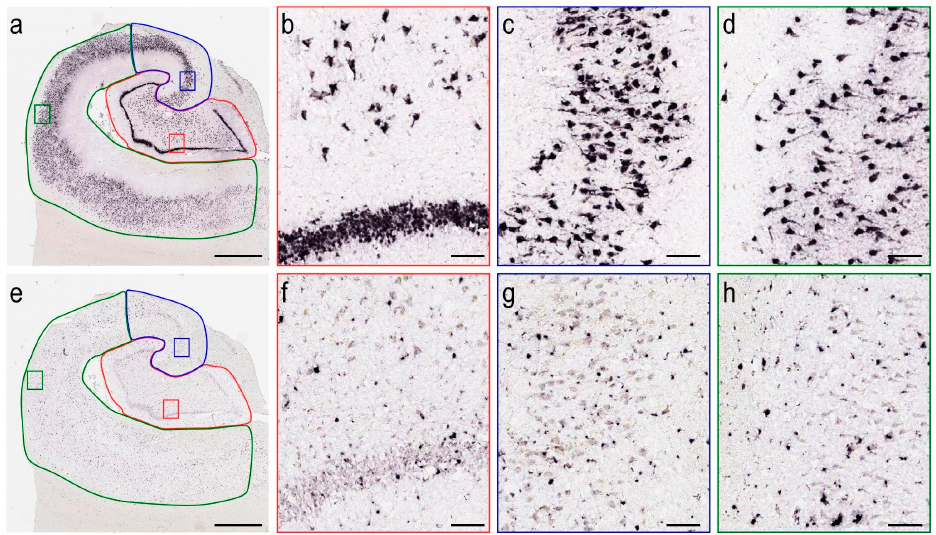
Figure 2. VGLUT1 and GAT1 mRNA immunoreactive profiles in the hippocampal sub-regions. This material was obtained from the donor H14.09.074. VGLUT1 ( a ) positive cells are observed at high-resolution in the DG (red, ( b )), CA3/2 (blue, ( c )), and CA1 (green, ( d )). GAT1 ( e ) positive cells are observed at high-resolution in the DG (red, ( f )), CA3/2 (blue, ( g )), and CA1 (green, ( h )). Images were obtained from the Aging, Dementia and TBI study database and are publicly available at: http://aging.brain-map.org/ (accessed on 14 October 2022). Anatomical charts were produced by the authors of the present work. Scale bars 2000 µ m ( a , e ) and 200 µ m ( b – d , f – h ). The percentage of the area (area fraction) occupied by VGLUT1 and GAT1 staining was estimated through the area fraction fractionator stereological methodology [47]. This was performed in a built-in function of the software StereoInvestigator v11.0 (MBF